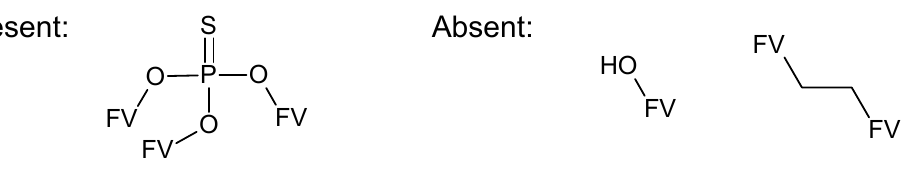
Figure A13. Substructures for GC–MS Challenge 14. FV = free valence.